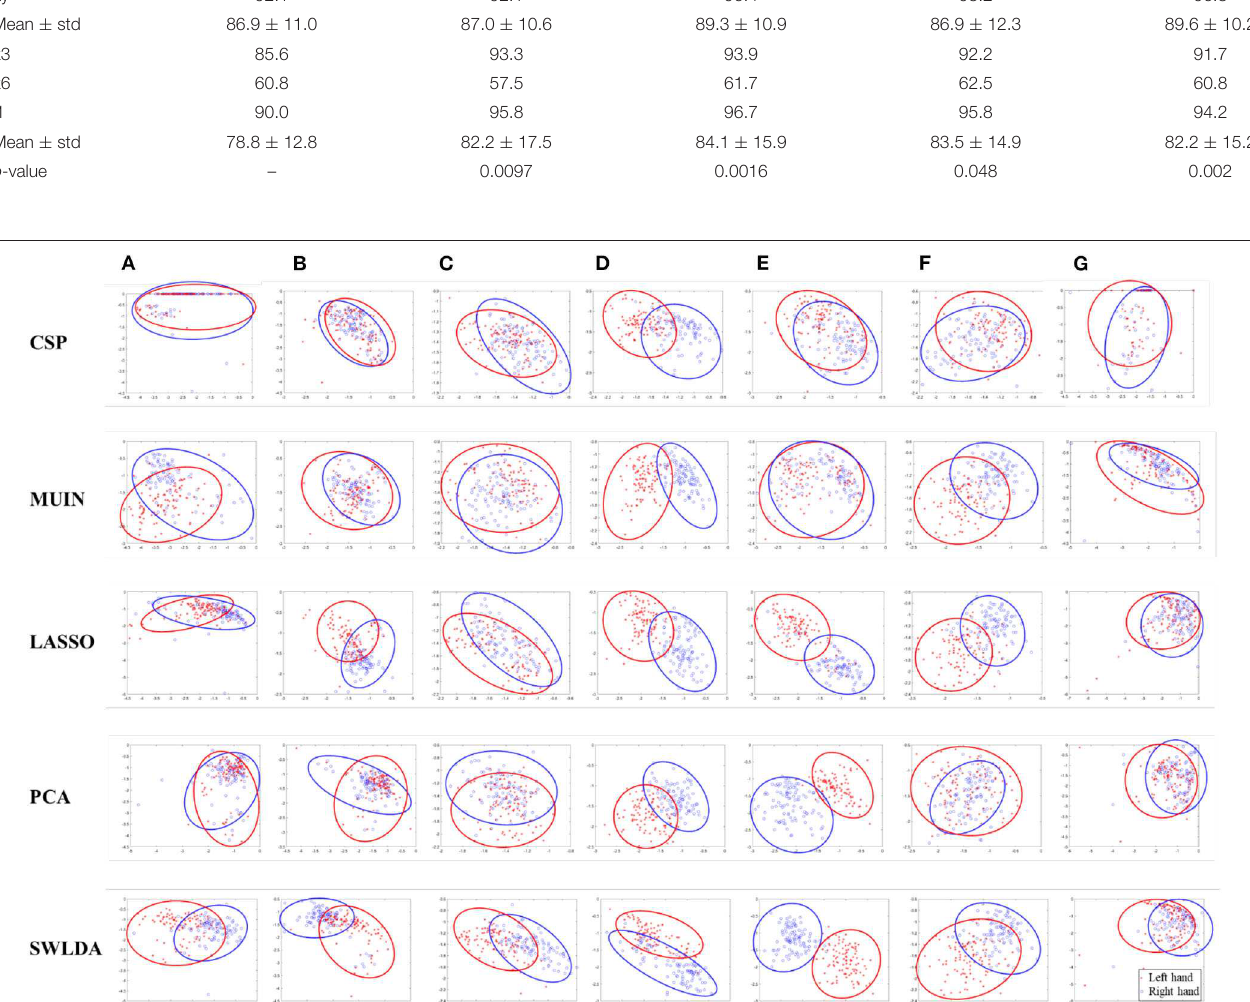
FIGURE 3 | A two-dimensional feature distribution map for each class obtained by using traditional method and the proposed feature selection-based algorithms (i.e., MUIN, LASSO, PCA, SWLDA) in dataset 1 [subjects (A–G) ].